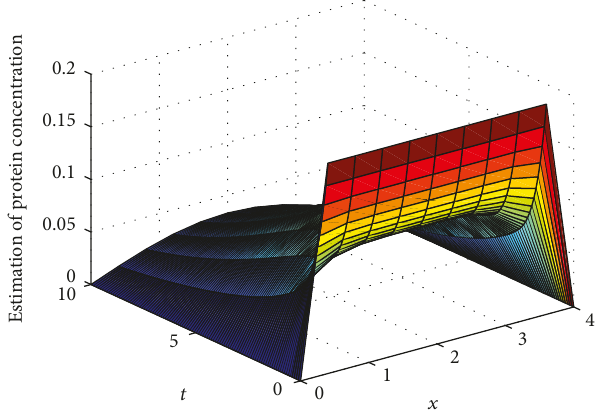
Figure 4: The estimation protein concentrations by the 1 -order observer ( ̂ p t , x ). 2